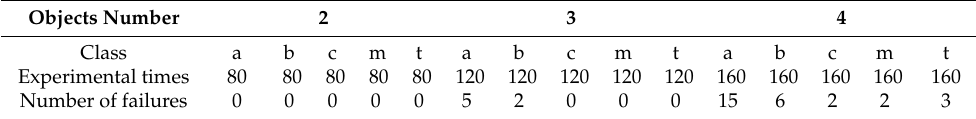
Table 6. The grasping results.